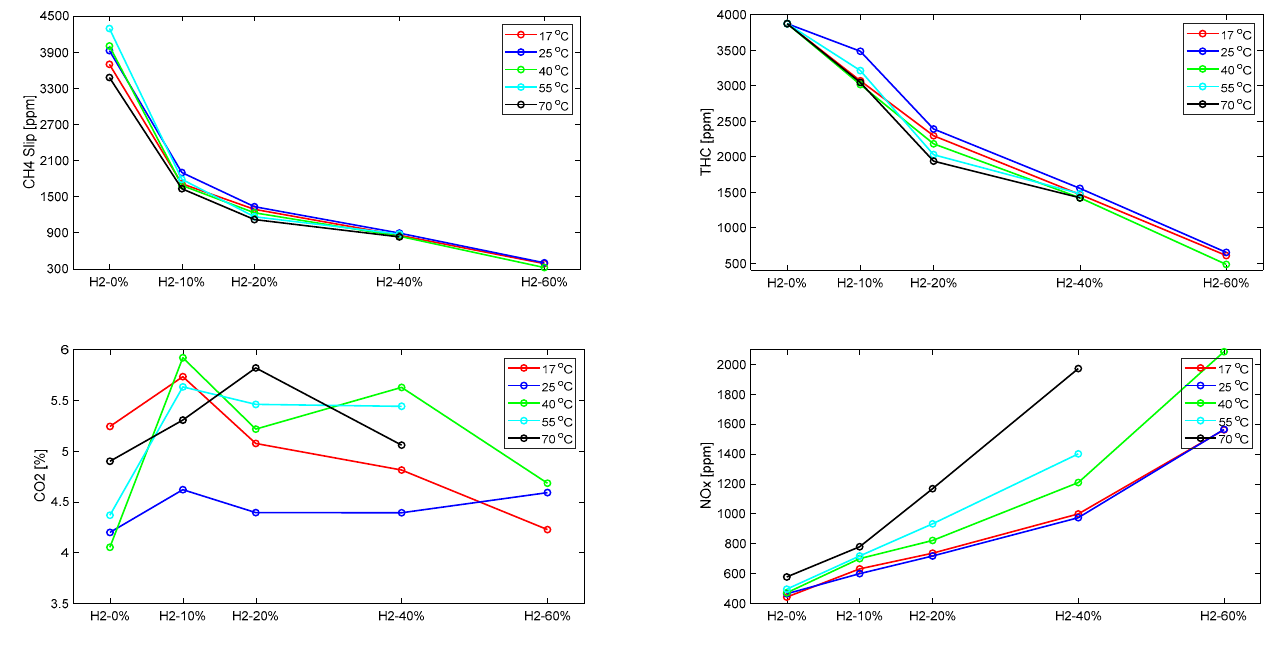
Figure 7. The effect of H 2 addition on the engine emissions under various charge-air temperatures in a full-metal single-cylinder engine.